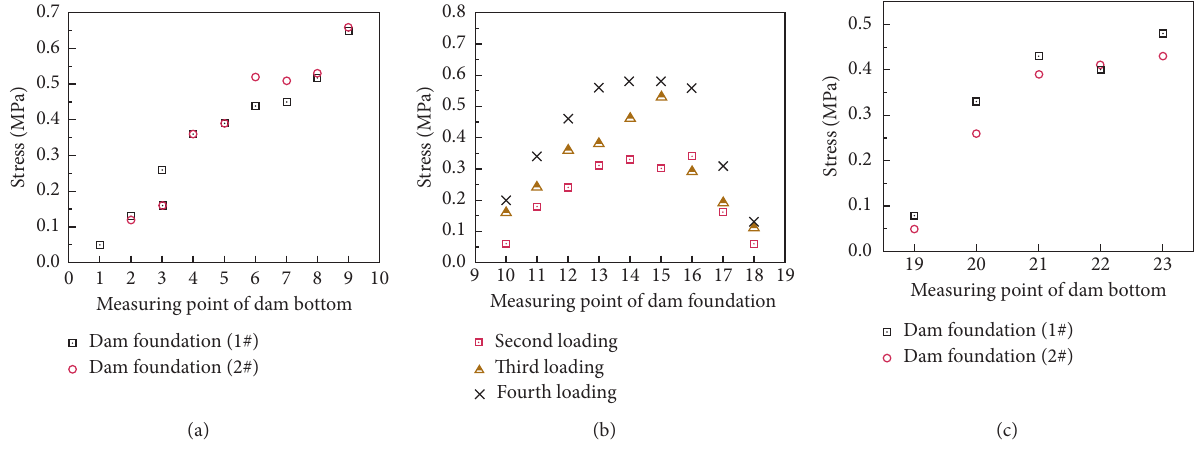
Figure 6: Stress survey map during normal operation period.